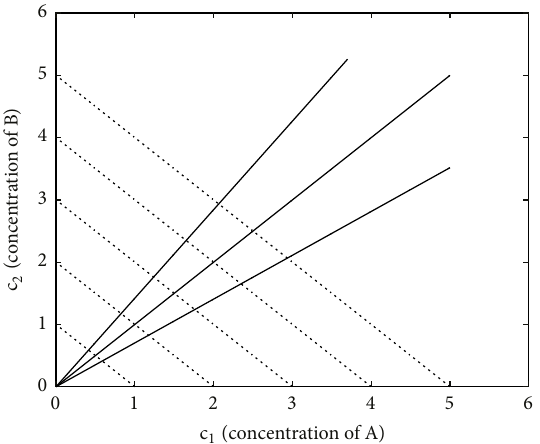
Figure 6: Example 2: equilibria (solid lines) for 𝛼 = 0.16 , 𝛽 = 1 in different compatibility classes (dashed